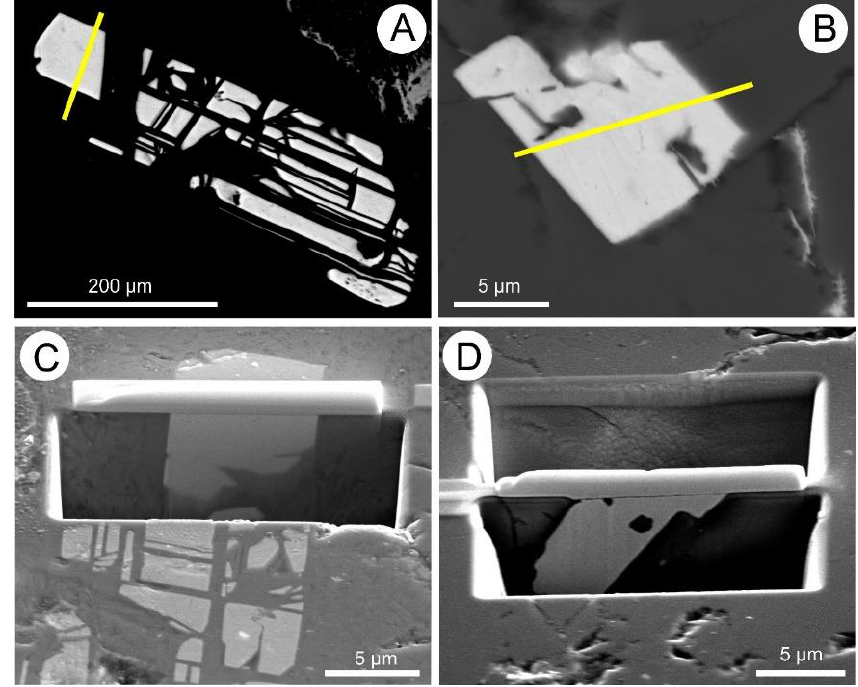
Figure 3. BSE images ( A , B ) and secondary electron images ( C , D ) showing the two joséite-A grains cut across (yellow lines show the FIB cuts) for TEM foils. Cross-section imaging of the two grains ( C,D ) showing the extension of the grains at depth. Note small size and intense fracturing of the tellurides. Table 2. Electron probe microanalysis data for laitakarite